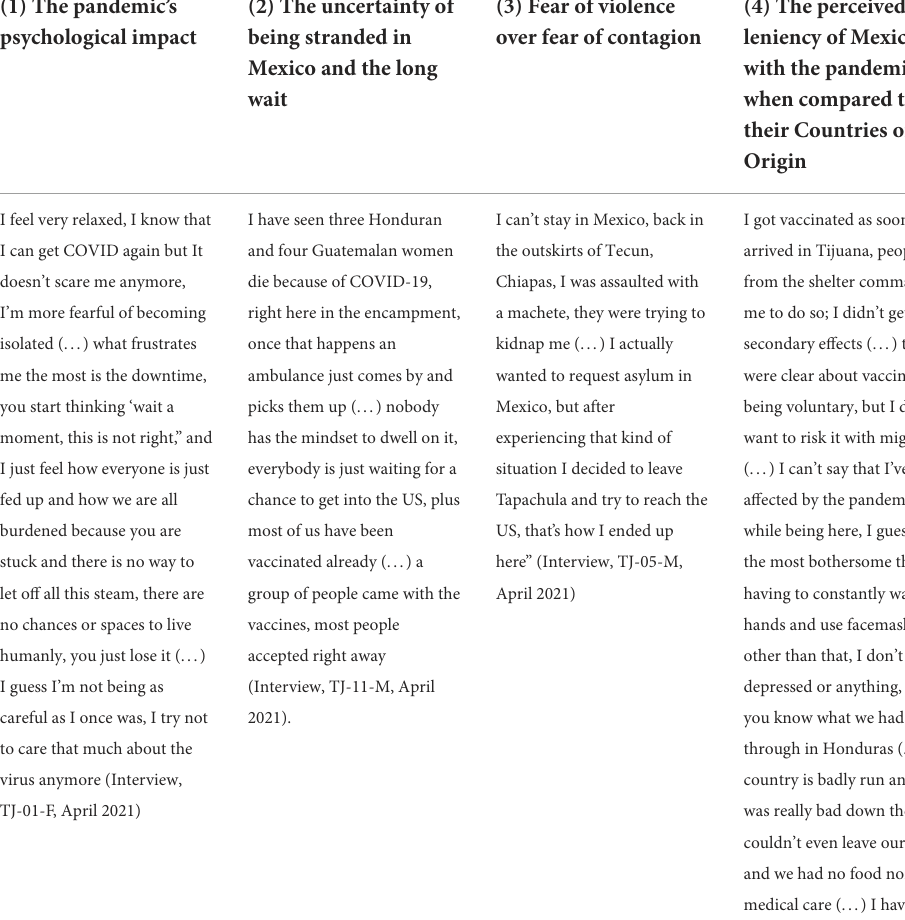
TABLE 3 Quotations regarding each of the five recurring themes within each narrative. (1) The